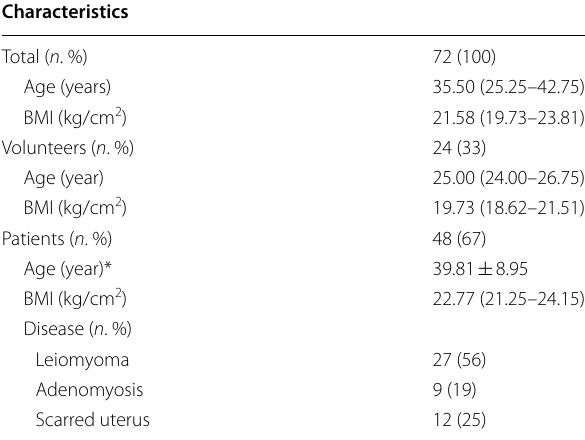
Table 1 Characteristics of the study